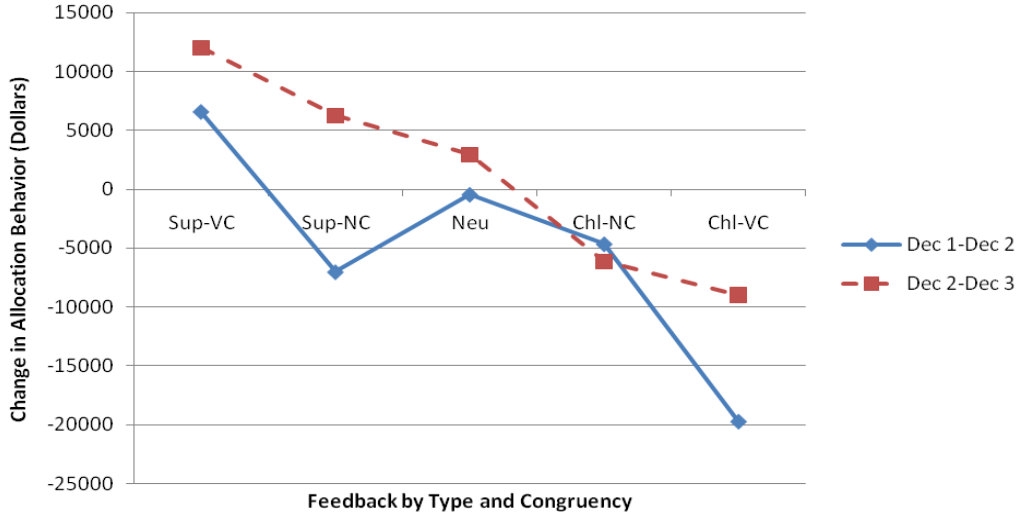
Figure 5. The Effect of Feedback and Value Congruency on Allocation Behavior between Decisions.